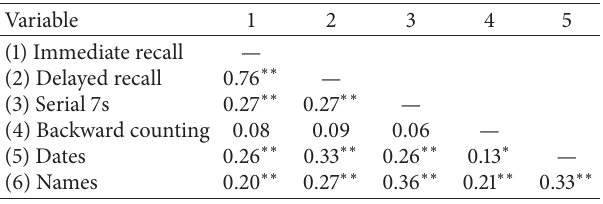
Table 3: Correlations among cognitive